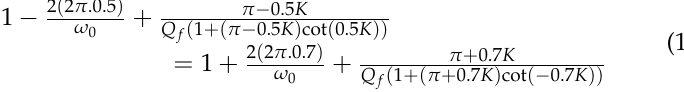
and 𝐾 = 0.079 ; ( b ) and K = 0.079; ( b ) APJPF 𝑜 o = 0 . = 0 0